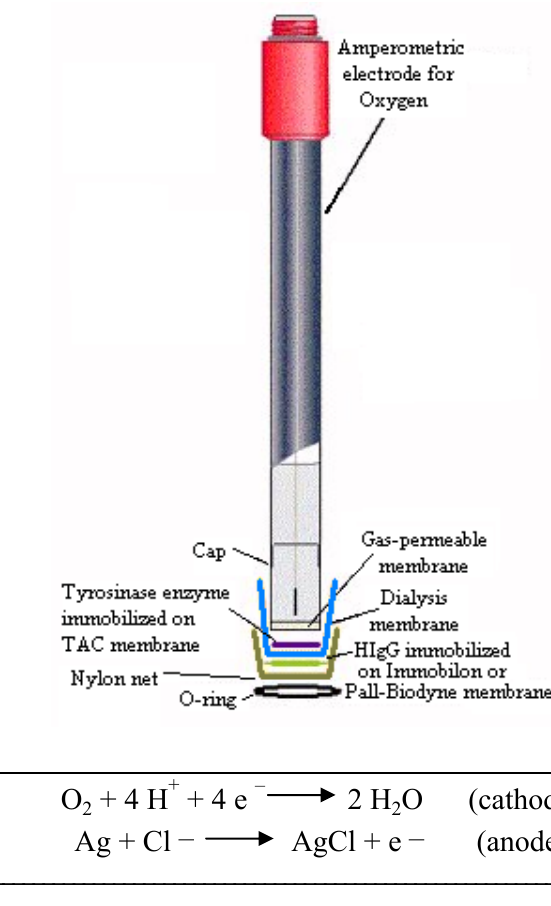
Figure 1. New immunosensor